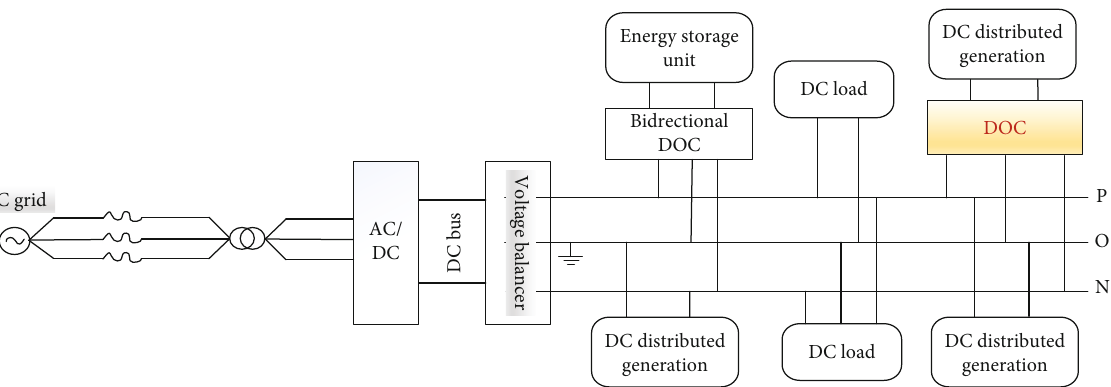
Figure 1: Structure of the bipolar DC microgrid.